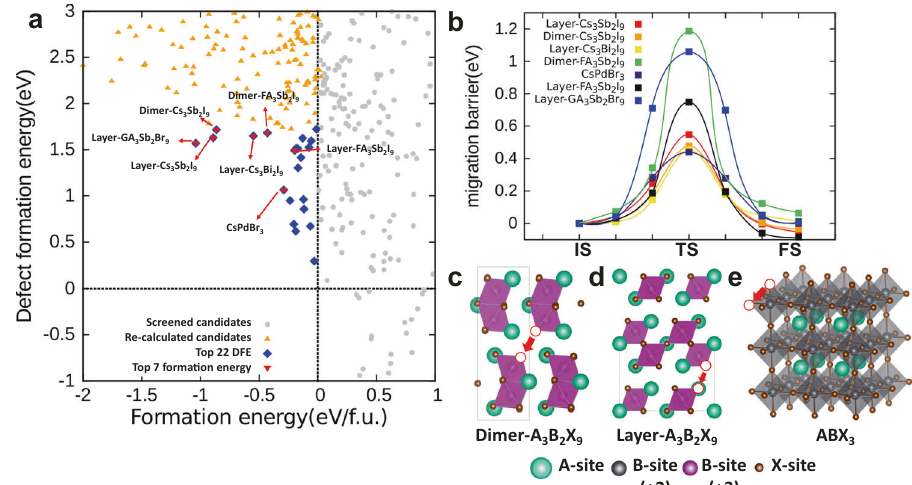
Fig. 2 High-throughput screening for HP RSM. a Formation energies and halide vacancy defect-formation energy of 696 types of candidates. Through four-step screening, the candidates are fi ltered by 236 possible compositions (yellow), top 22 by defect-formation energy fi ltering (blue), and top 7 by formation energy and phase fi ltering (red). The gray circles are excluded candidates due to their positive formation energy. b A vacancy-migration barrier of top seven candidates (IS initial state, TS transition state, FS fi nal state). Schematic structures of c dimer-A 3 B 2 X 9 , d layer-A 3 B 2 X 9 , and ( e ) ABX 3 (red circle: halide vacancy site, red arrows: vacancy-migration paths). The rectangular boxes in schematic structures are the unit cell of crystal